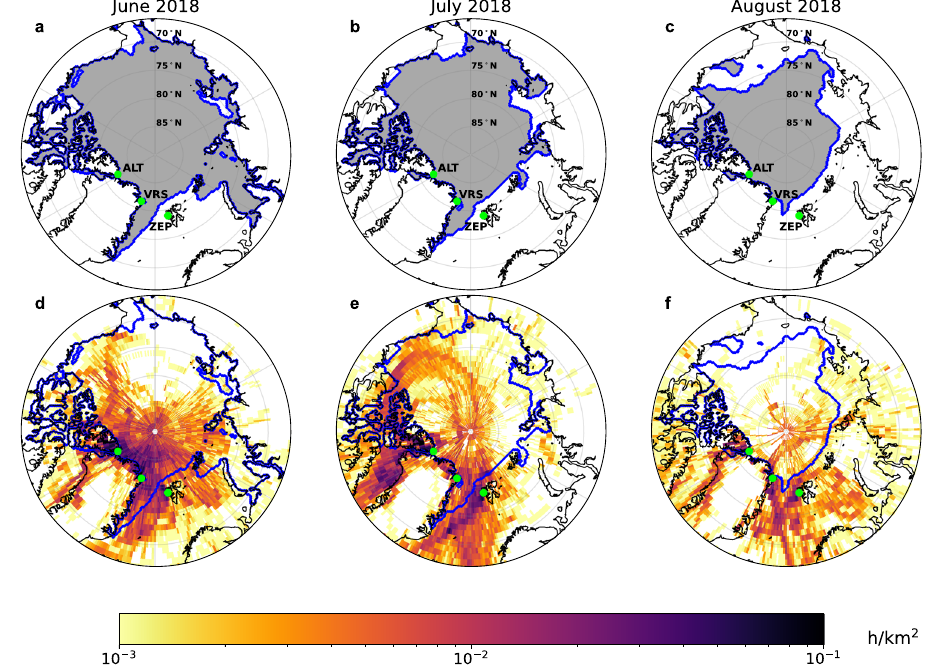
Fig.6|SeaiceextentandoriginofairmassesarrivingatZeppelin(ZEP),Villum (VRS)andAlert(ALT)researchstationsfromJunetoAugust2018. Seaiceextent (all panels, blue line) and air mass residence time maps (lower panels, hours per km 2 ) for combined 10-day HYSPLIT back trajectories from ZEP, VRS and ALT. Residence time was calculated only for trajectories within the atmospheric boundarylayer.Themapsdisplayseaiceextentandairmassresidencetimefor a , d